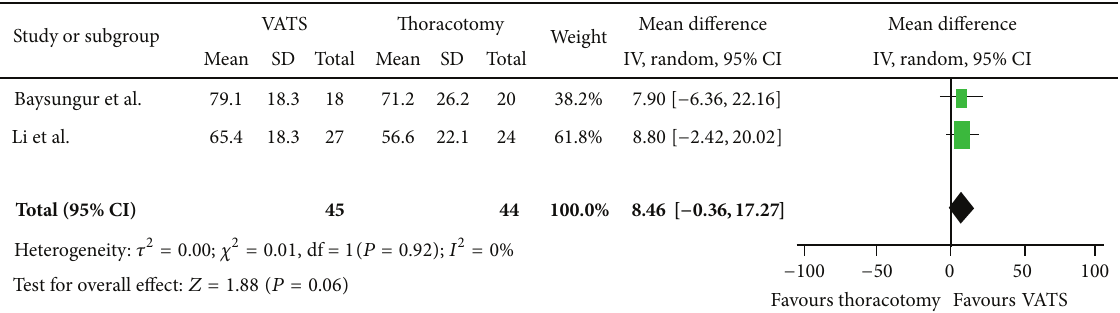
Figure 2: Forest plot for Global Health comparing VATS to